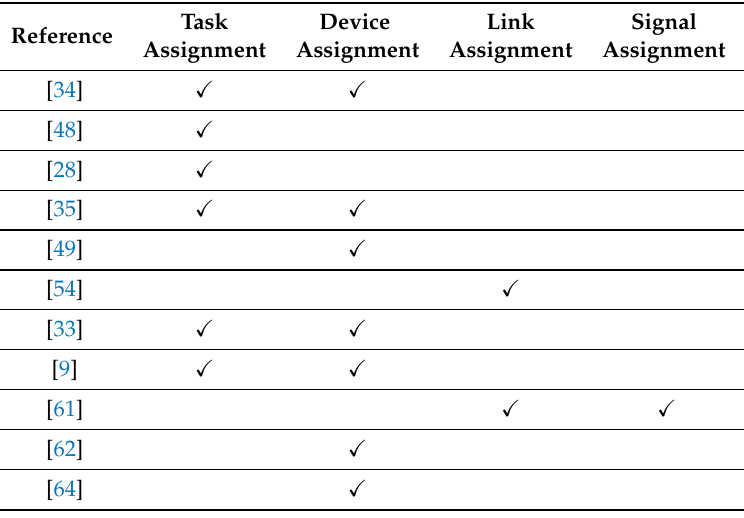
Table 1. DIMA optimization under different